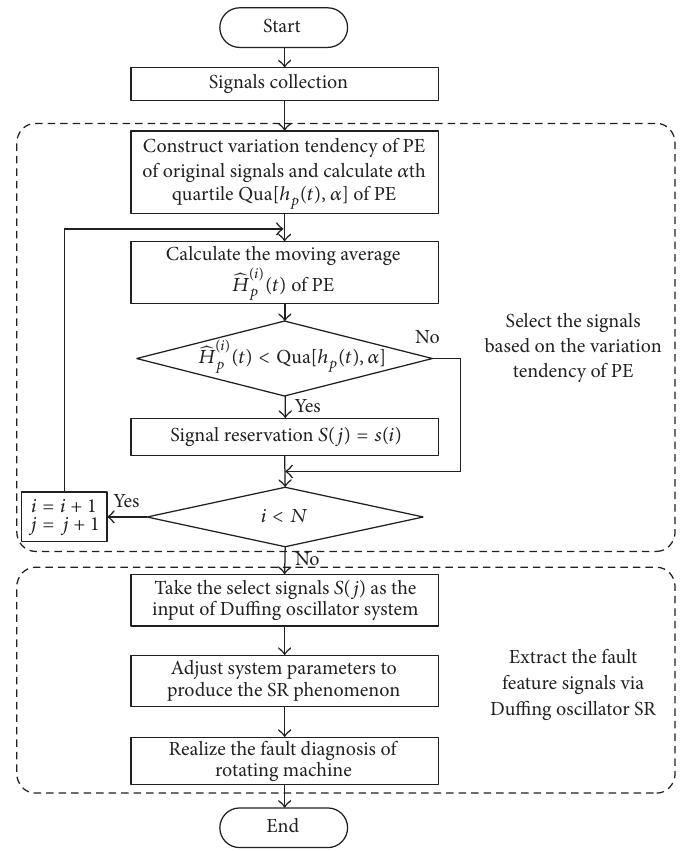
Figure 9: Flow chart of the proposed method.